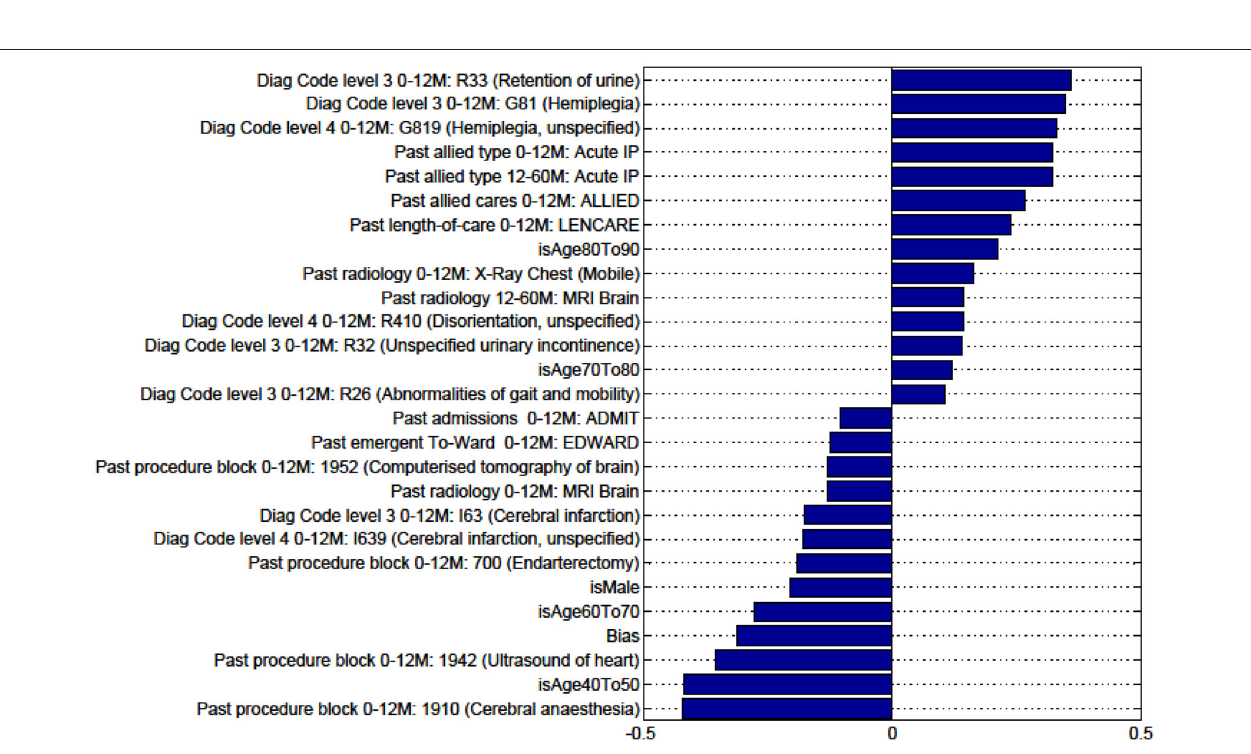
FIGURE A6 | Factors for prediction of Discharge to Rehabilitation vs Home for the sub-cohort of ischemic stroke patients.